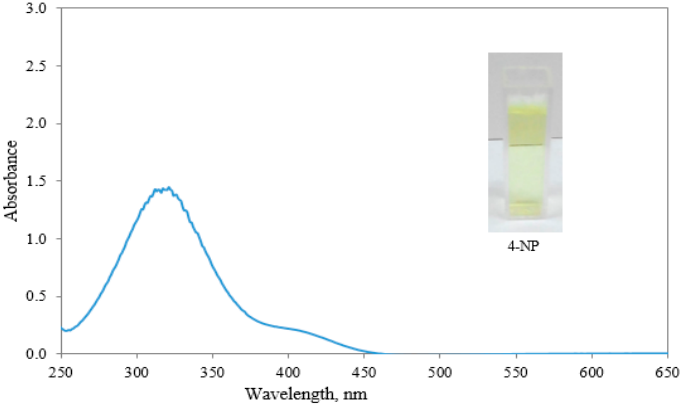
Figure 8. Absorption spectra of 4 ‐ NP without reducing agent.